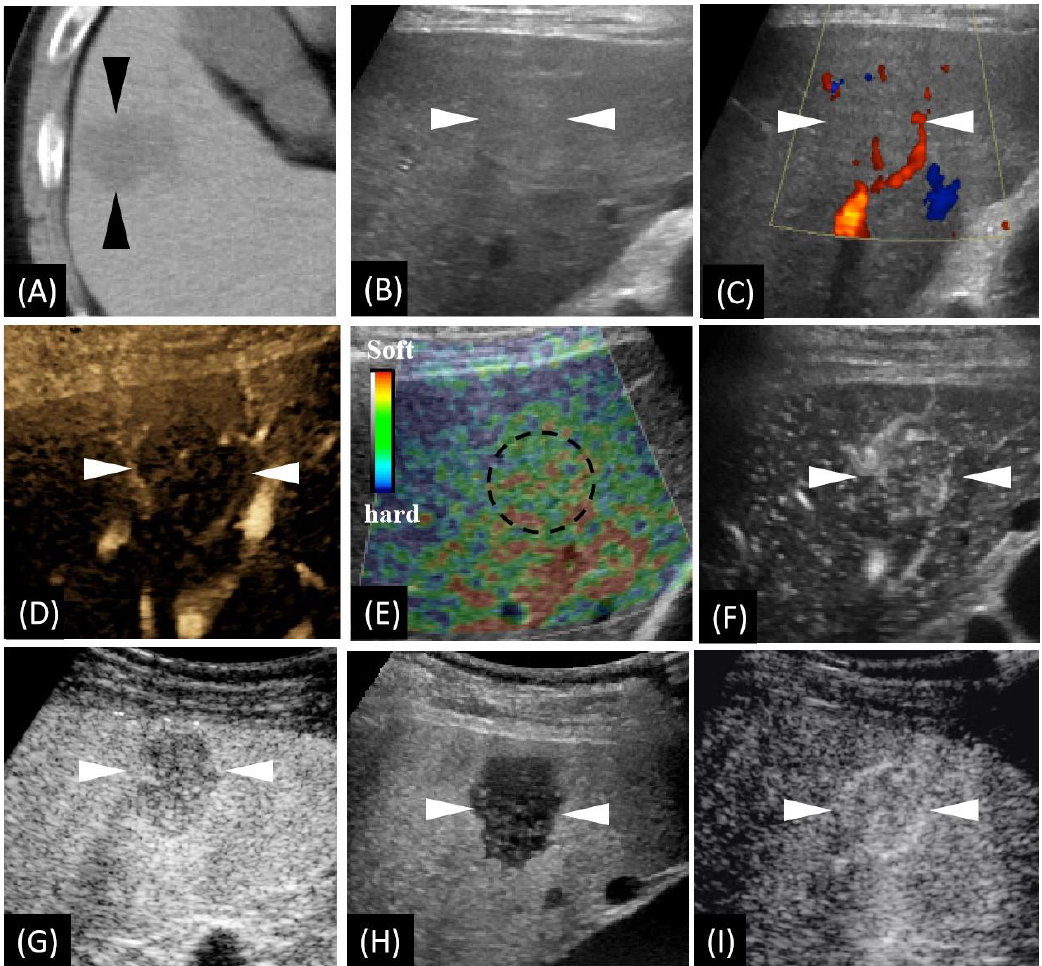
Figure 1. Unenhanced computed tomography (CT) and ultrasound (US)-based multimodal imaging of sclerosed hemangioma (HSH) at first detection (our case, a 57-year-old male patient). ( A ) Axial CT image shows the largest cross-sectional area of the tumor in the routine unenhanced phase. ( B ) Grayscale US shows a slightly hyperechoic lesion in segment V, near the surface of the liver. There is neither halo sign surrounding nor mosaic sign within the lesion. ( C ) Color Doppler flow imaging shows there is no significant blood flow within the lesion, while there is a relatively rich blood flow signal in the surrounding liver parenchyma. ( D ) B-flow imaging exhibited a central faint blood flow and peritumoral strips of blood vessels. ( E ) US elastography showed dotted and flaky red and green mixed images dominated by green. ( F ) Using low mechanical index (MI) harmonic imaging, arterial phase (10 – 50 s after initiation of injection) Sonazoid contrast-enhanced US shows hypervascularity with centripetal vessels. ( G , H ) Slight hypovascularity is shown in the portal phase (80 – 120 s after initiation of injection) ( G ), while marked hypoechogenicity with distinct margins is shown in the post-vascular phase (10 min after initiation of injection) ( H ). ( I ) Re-injection of Sonazoid agent shows hypervascularity in the arterial phase. The arrowheads seen in images A – D and F – I and the dotted circle in image E indicate the margin of the lesion.